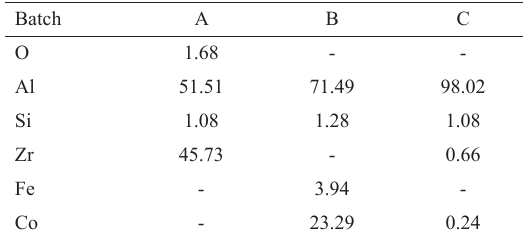
Figure 6: EDX analysis of points A, B and C in figure 5b Table 3: Elemental compositions of points A, B and C of figure